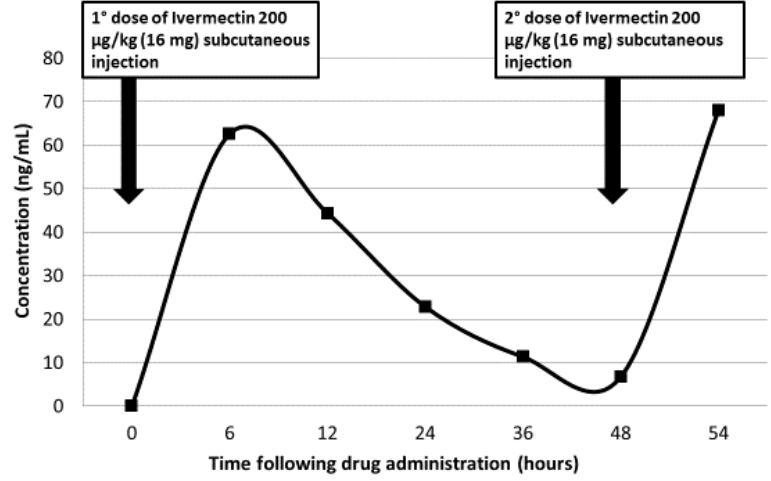
Figure 1. Plasma ivermectin concentrations after two parental administrations.